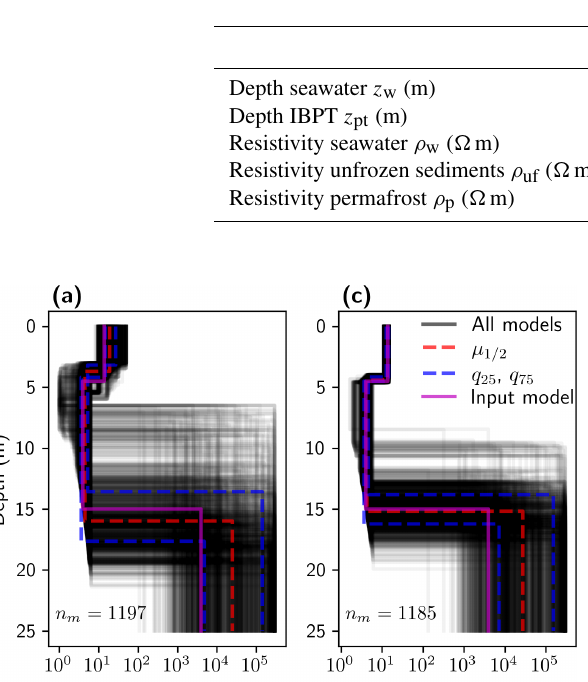
Table 2. Parameters of the 1D synthetic model of Bykovsky and for two scenarios indicating the lower and upper bound parameter constraints.